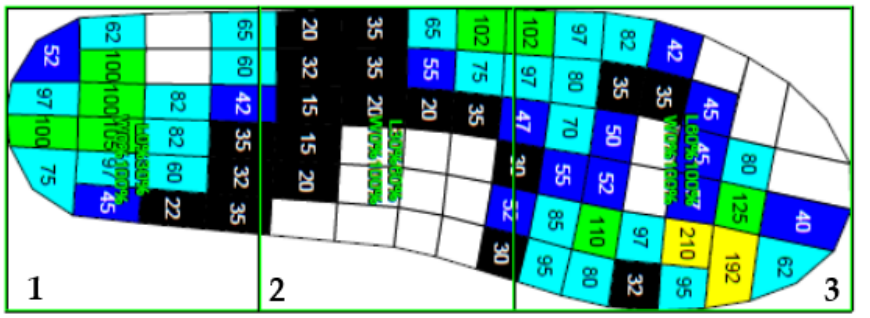
Figure 2. Three zones of segmentation of the foot (1—0% to 30% of total length; 2—30% to 60% of total length; 3—60% to 100% of total length). Obtained from Novel Multiprojects-e (v 24.3.34, Novel, Munich, Germany).